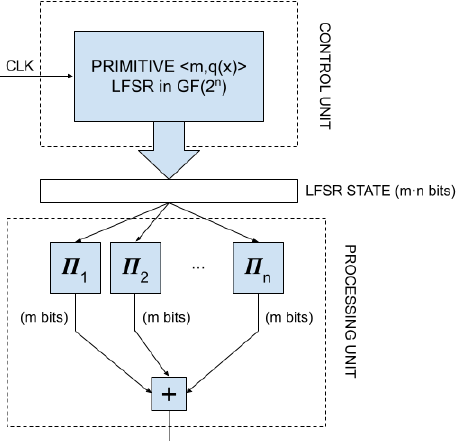
Figure 3. Gaussian number generator